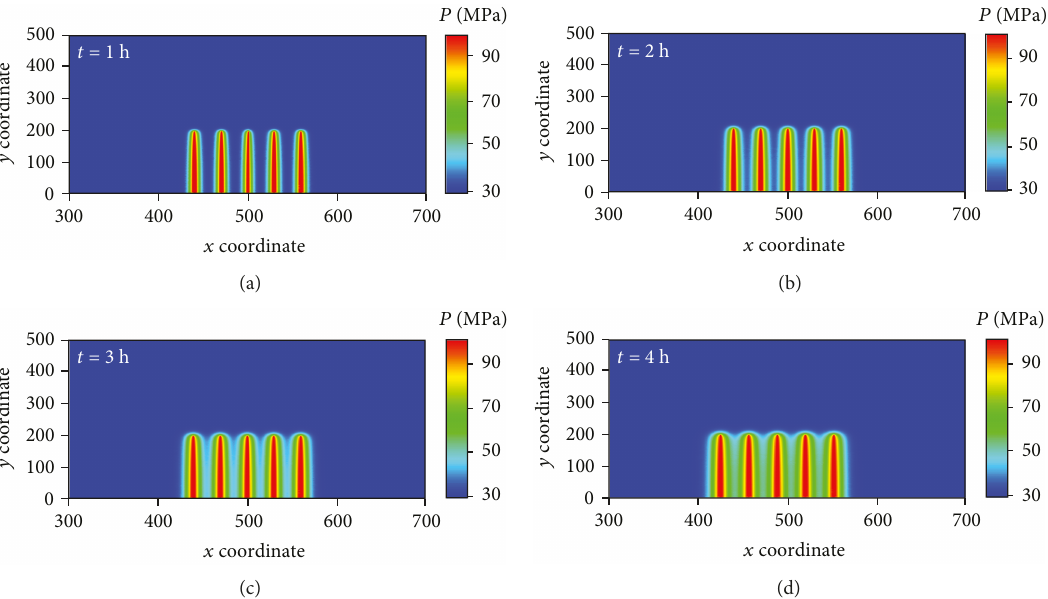
= 30 MPa, and Δ P = 70 MPa): 0